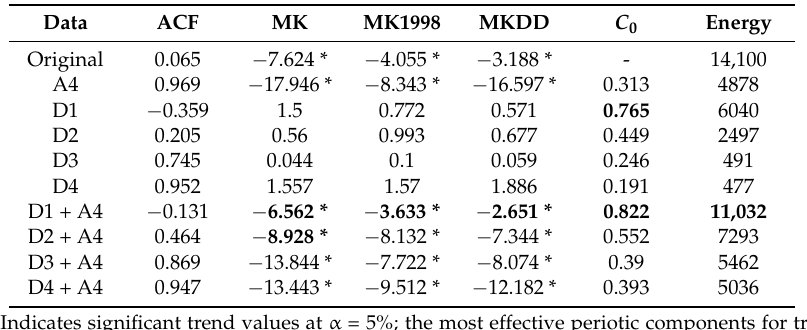
Table 6. Lag-1 ACFs, Mann-Kendall values and energy of seasonal mean streamflow series: original data, details components (D1–D4), approximations (A4) and a set of combinations of the details and their respective approximations. C 0 is the correlation coefficients between the decomposition combinations and the original series.